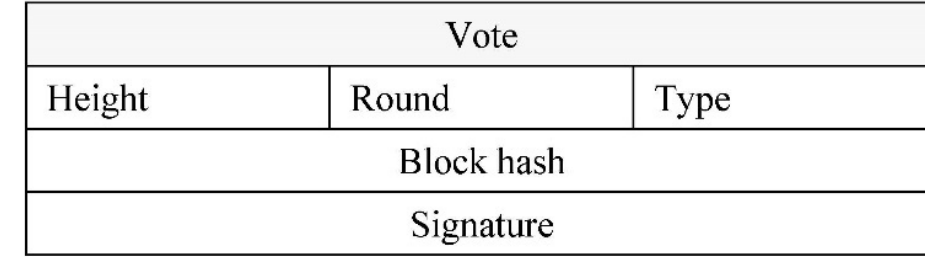
Figure 3. Vote structure.